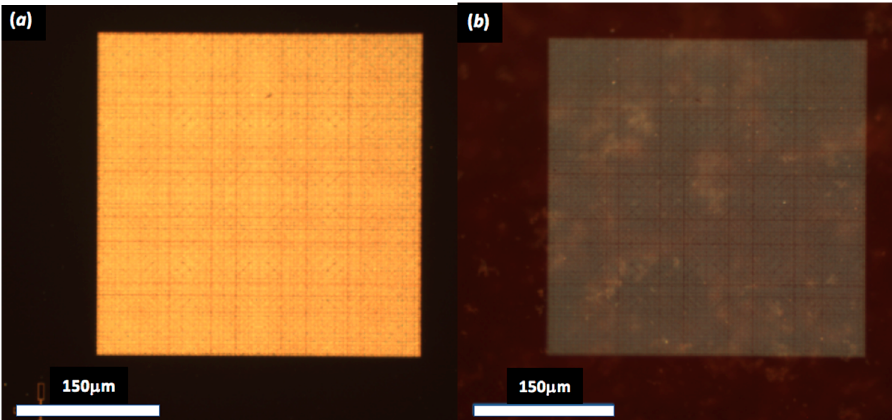
Figure 3. Dark Field Microscopy (DFM) of plasmonic aperiodic crystals (octagonal symmetry) placed: ( a ) on a rigid substrate (glass slide) and ( b ) its complementary nestled on PMP film. Magnification: 20×. The image is collected by an Olympus optical microscope equipped by a Charge Coupled Device CCD camera connected to a computer. The length scale is shown by the white bar (150 µm) at the bottom of the figures.